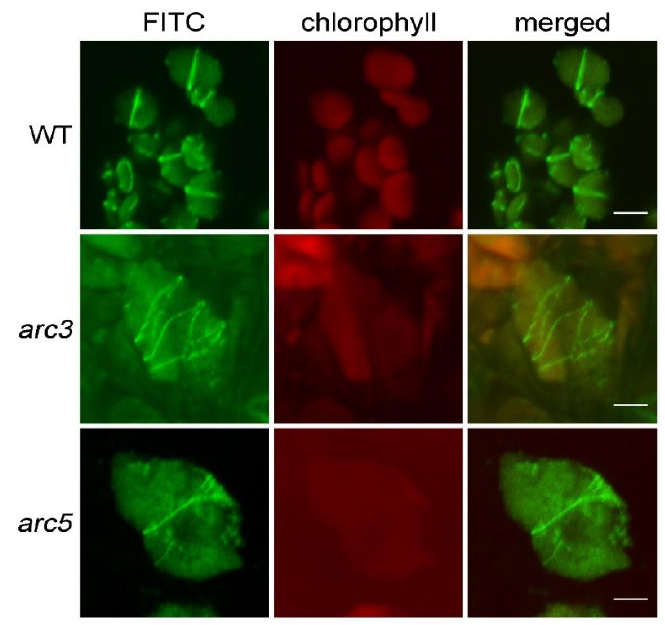
Figure 2. Direct observation of the immunofluorescence of FtsZ1 in Arabidopsis with a confocal microscope. WT, wild type; arc3 and arc5 are two chloroplast division mutants. Bars = 5 μm.